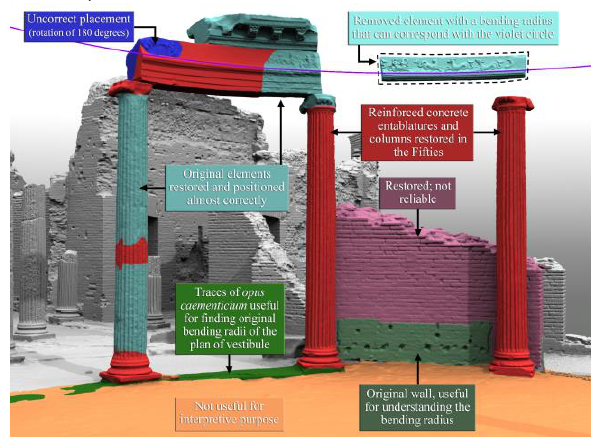
Figure 9. Semantic enrichment cannot be carried out properly without interdisciplinary contributions: in particular it